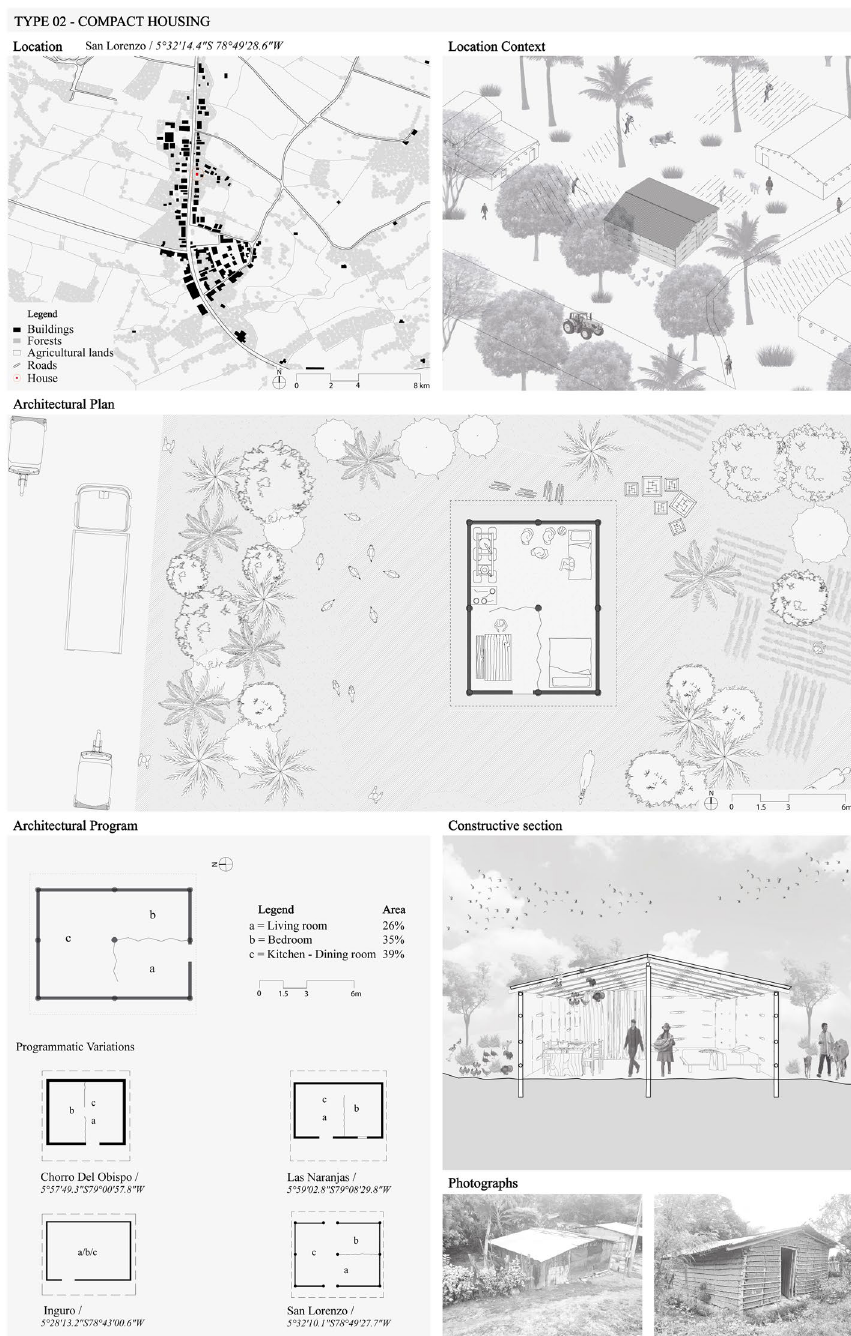
Fig. 3 Architectural characteristics of the compact housing type (Source: the